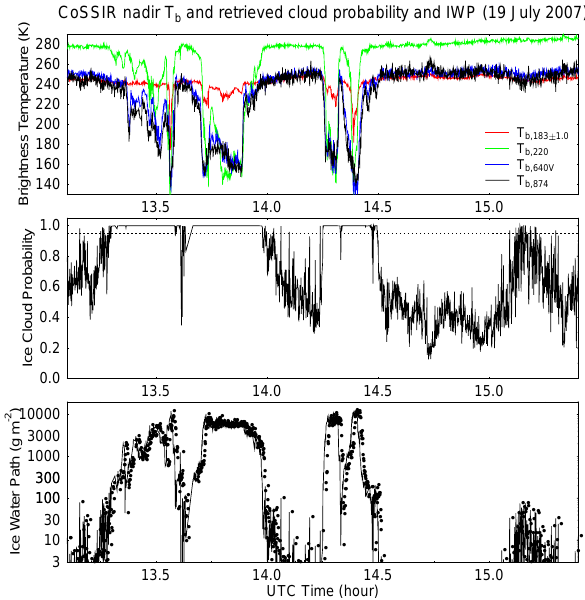
Fig. 8. CoSSIR retrieved ice water path (top panel), D me (middle panel), and median IWP height (bottom panel) for cloudy nadir pix- els of the 19 July flight. 1- σ error bars are shown for each retrieved